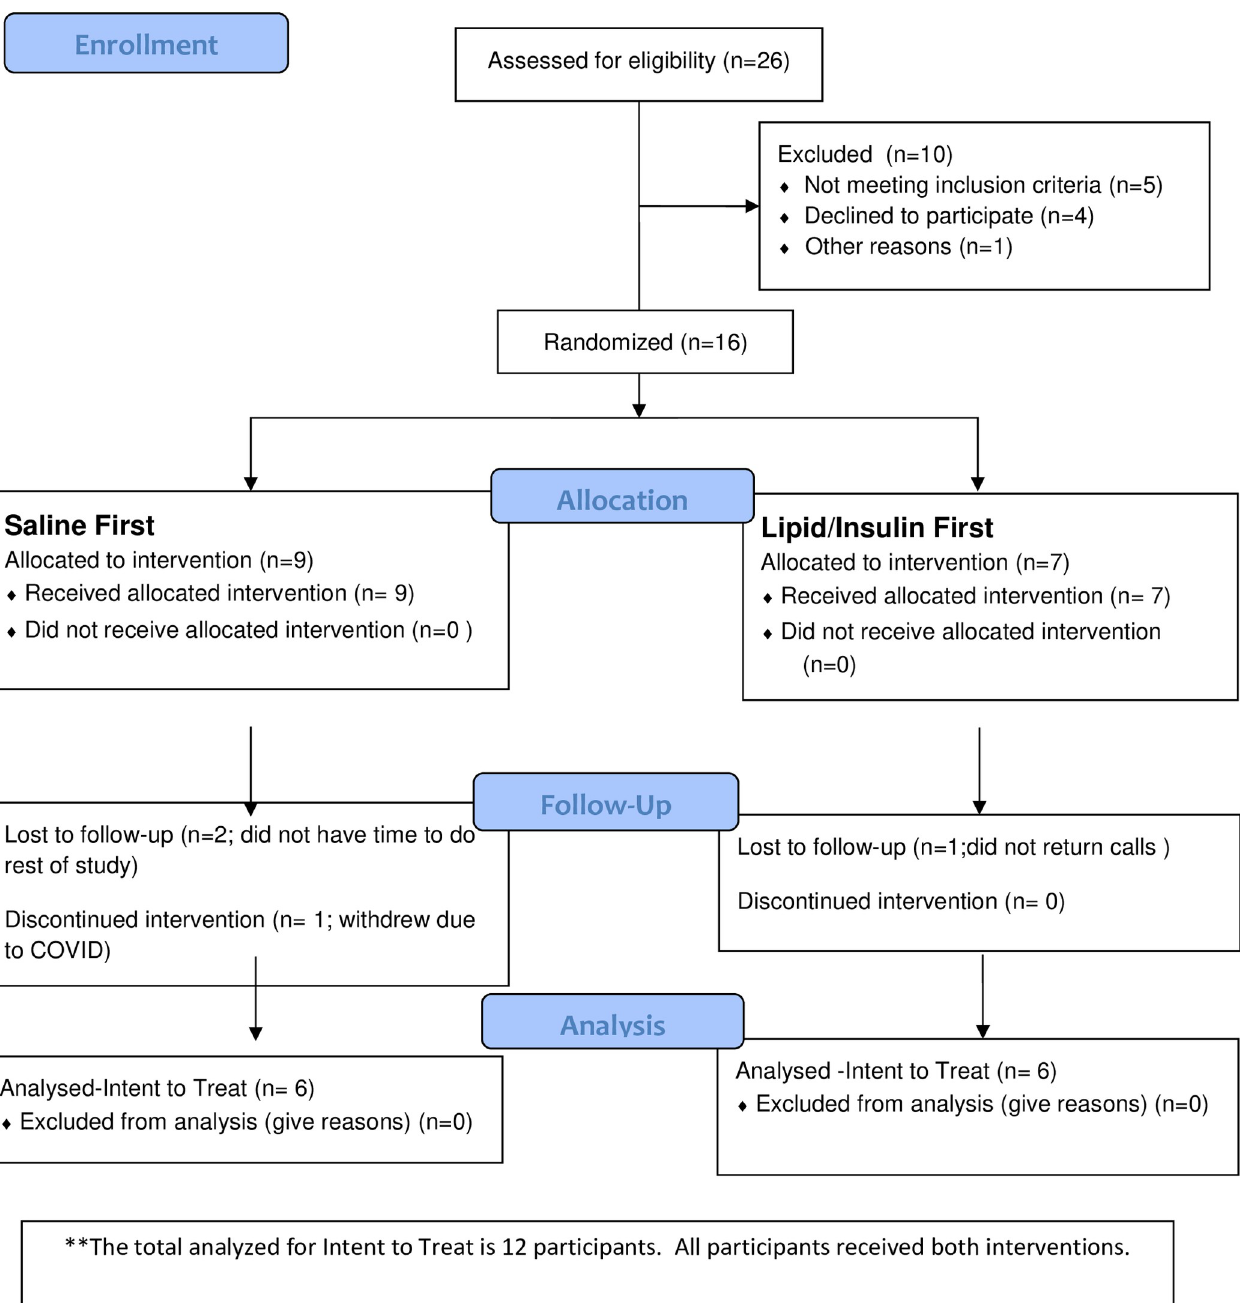
Fig 1. Flow diagram showing process for participant screening, enrollment and randomization for study visit infusions. The total participants analyzed was 12. https://doi.org/10.1371/journal.pone.0268323.g001 and 3.4% for GH, and < 12% and < 10% for IGF-1, respectively. Serum creatinine was mea- sured hourly in pooled samples. Inter and intra-assay CVS were 4.6% and 6.4%, respectively. Leptin and Adiponectin (high molecular weight; RRID:AB_2892778), were measured by